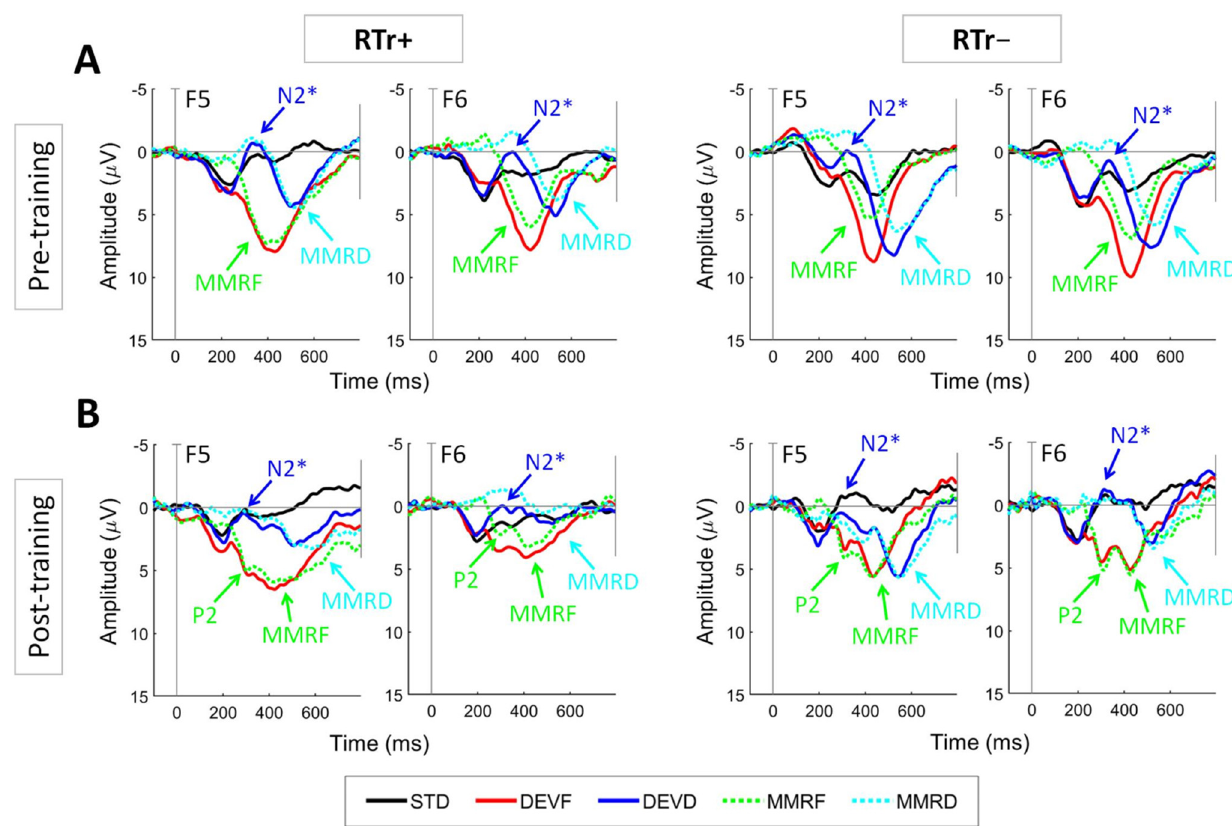
Figure 4. Grand average waveforms for RTr+ and RTr − infants at ( A ) pre-training and ( B ) post-training. Representative channels F5 and F6 located, respectively in the left and right frontocentral regions are shown. The standard waveform (STD, black line) is plotted against the waveforms for the frequency deviant (DEVF, red line) and the duration deviant (DEVD, blue line). In addition, the difference waveforms relative to MMRF (DEVF minus STD; green dotted line) and MMRD (DEVD minus STD; light-blue dotted line) are plotted. Plots were filtered using a 20 Hz low-pass filter for presentation purposes only. Negative voltage is plotted upward.